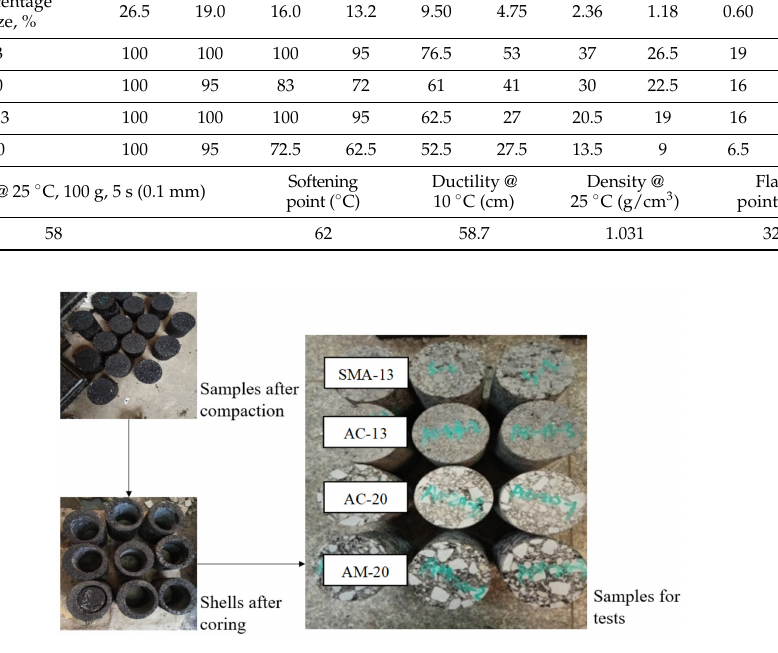
Figure 1. Asphalt mixture sample